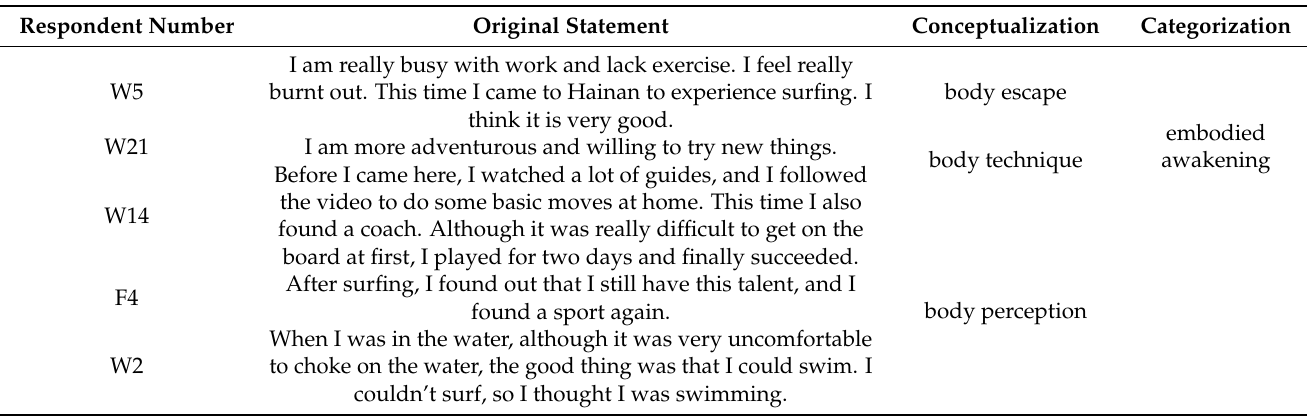
Table 2. Examples of open coding